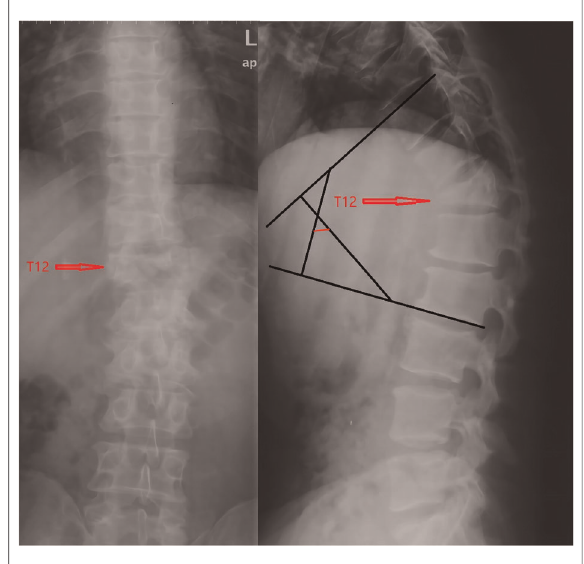
FIGURE 2 Anteroposterior and lateral radiographs of the thoracolumbar segment; Thoracolumbar cobb angle is